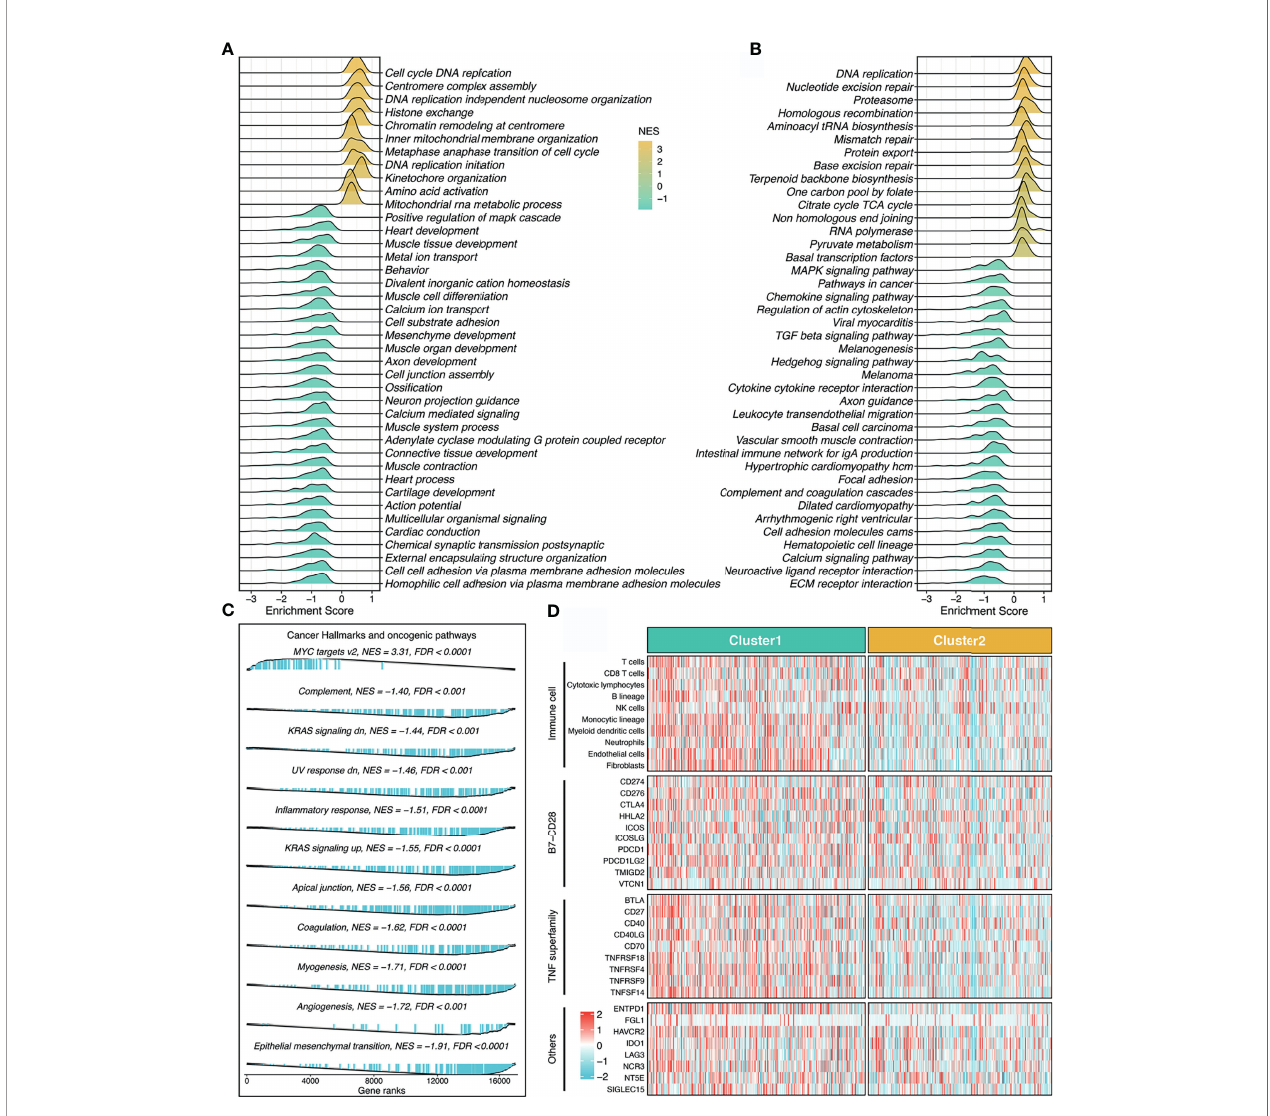
FIGURE 5 | Underlying biological pathways and distinct microenvironment patterns of two stemness clusters. (A – C) . GO (A) , KEGG (B) , and cancer hallmark (C) of gene set enrichment analysis (GSEA) according to the stemness clusters. (D) . The immune cell in fi ltrations and immune checkpoint pro fi les of two